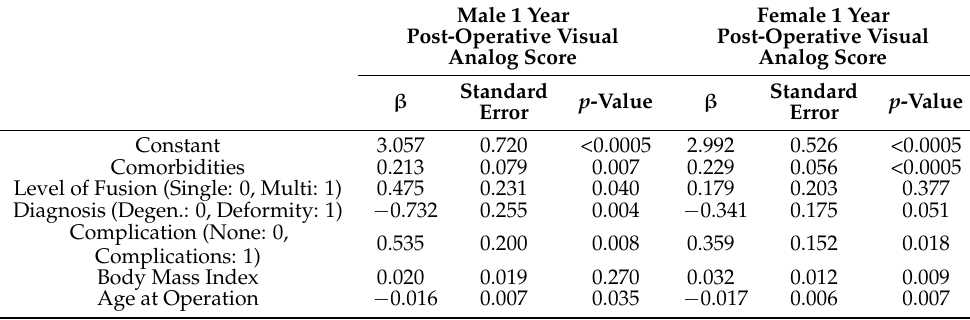
Table 7. Linear regression model of post-op VAS at 1 year for male and